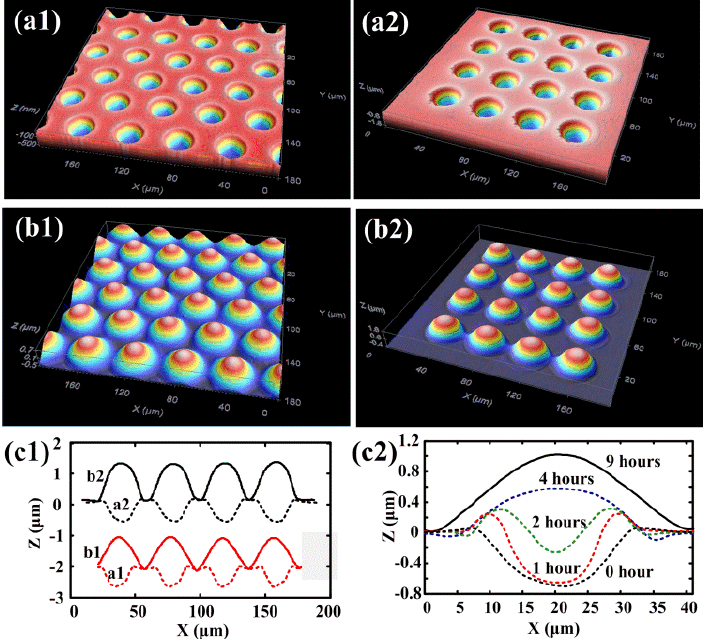
Figure 9. PMMA microlens arrays. ( a ) After indentation; ( b ) after immersion into room temperature ethanol; and ( c ) surface profiles at different stages during processing. (Reproduced with permission from [103]. Copyright 2011 The Optical Society (OSA)).